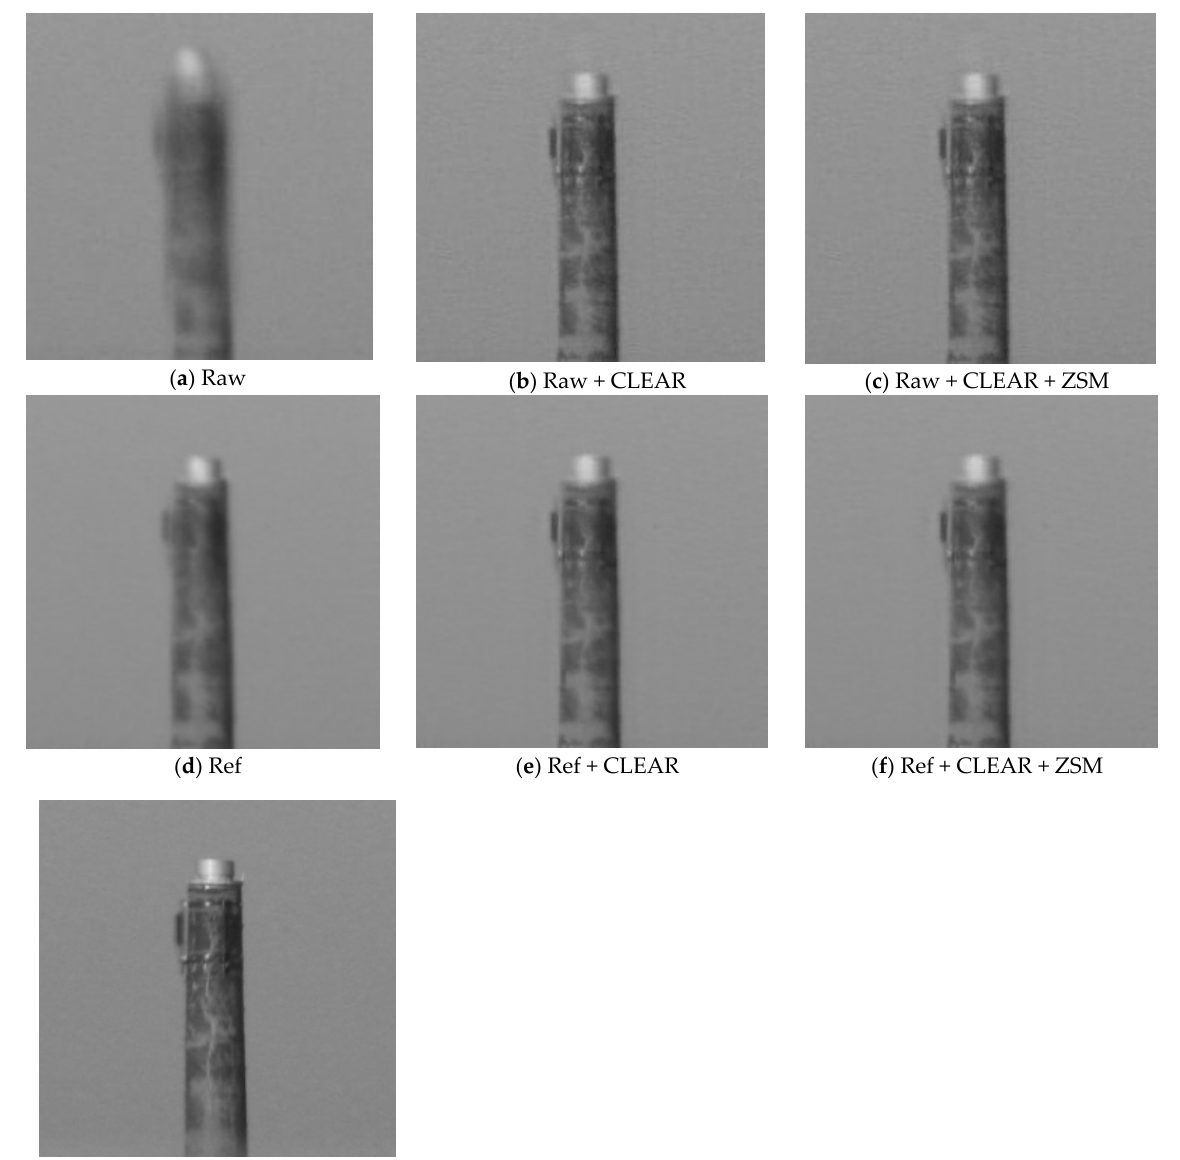
Figure 8. Method comparisons of the ‘Chimney’ sequence. ( a ) Raw; ( b ) Raw+CLEAR; ( c ) Raw+CLEAR+ZSM; ( d ) Ref; ( e ) Ref+CLEAR; ( f ) Ref+CLEAR+ZSM; ( g ) Ground truth.